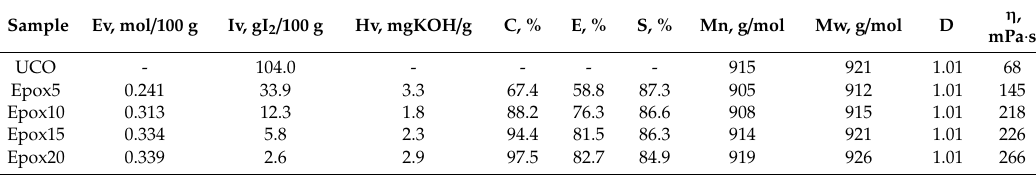
Table 1. Characteristics of epoxidized UCOs.